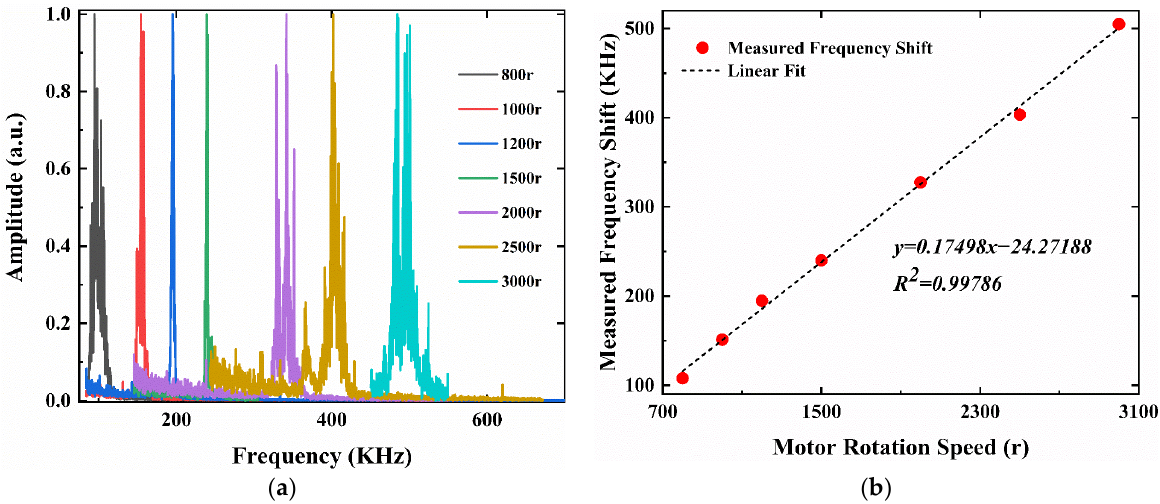
Figure 10. Measurement and fitting results of the speed of vapor with motor rotation speed range of 800 r to 3000 r. ( a ) Frequency shift wave packet; ( b ) The relationship between measured frequency shifts and motor rotation speeds.